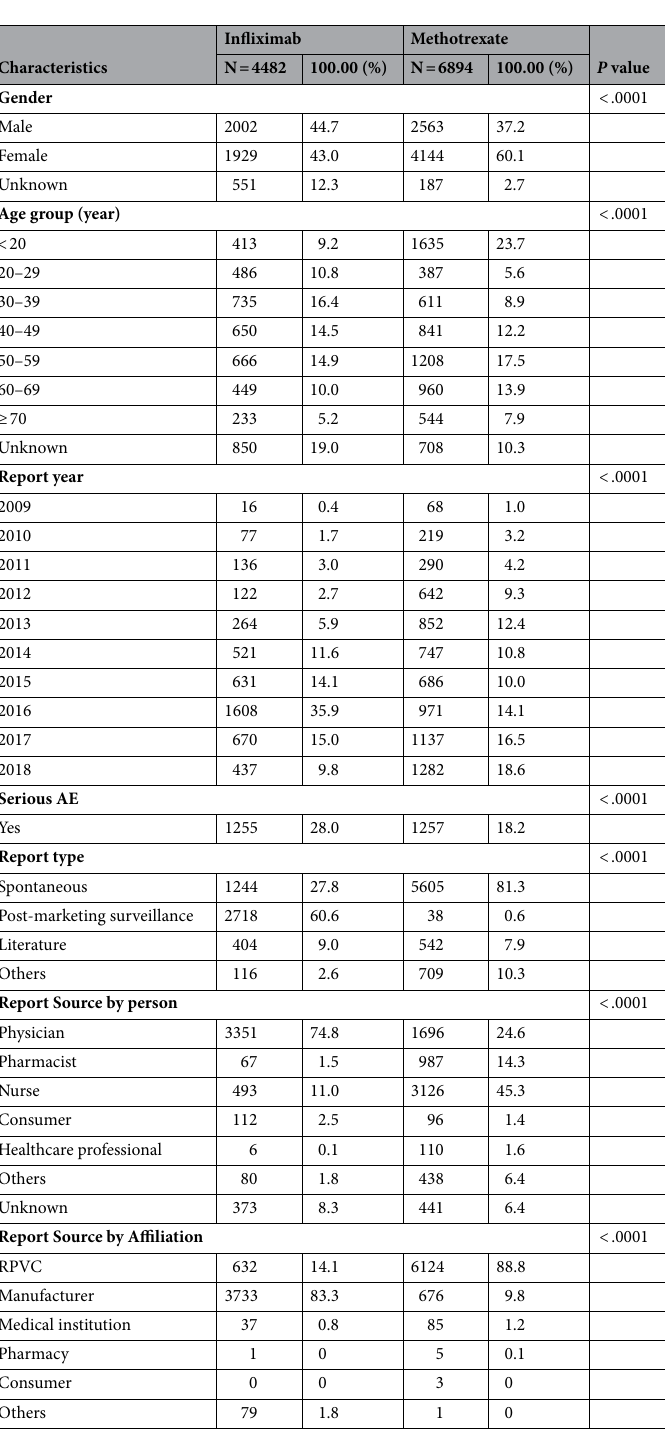
Table 1. Characteristics of the AE reports of infliximab and methotrexate in the KAERS between 2009 and 2018. AE adverse event, KAERS Korea Adverse Event Reporting System, RPVC regional pharmacovigilance